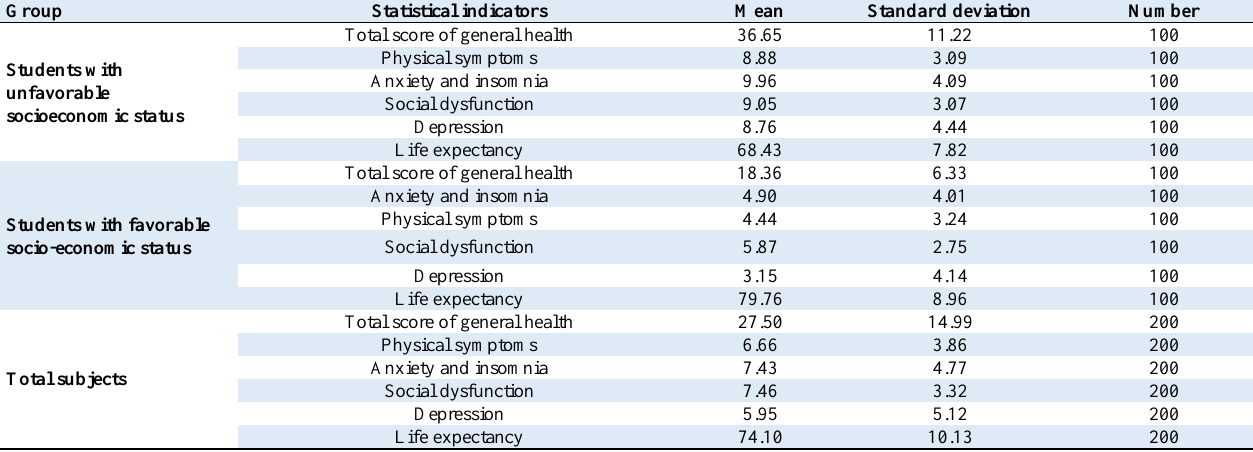
Table 1. The mean, standard deviation, and number of participants in general health scale (and its components) and life expectancy. Group